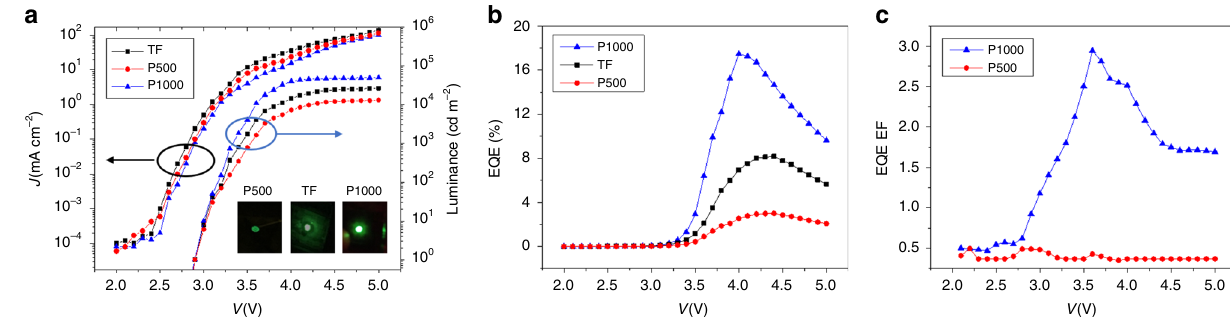
Fig. 2 Device performance. a J – V curve, Luminance and b External Quantum Ef fi ciency (EQE) of the thin fi lm (TF) and AAM samples. c EQE enhancement factor of AAM devices compared with the TF device. Inset fi gures in a are the optical photos for different devices driving at